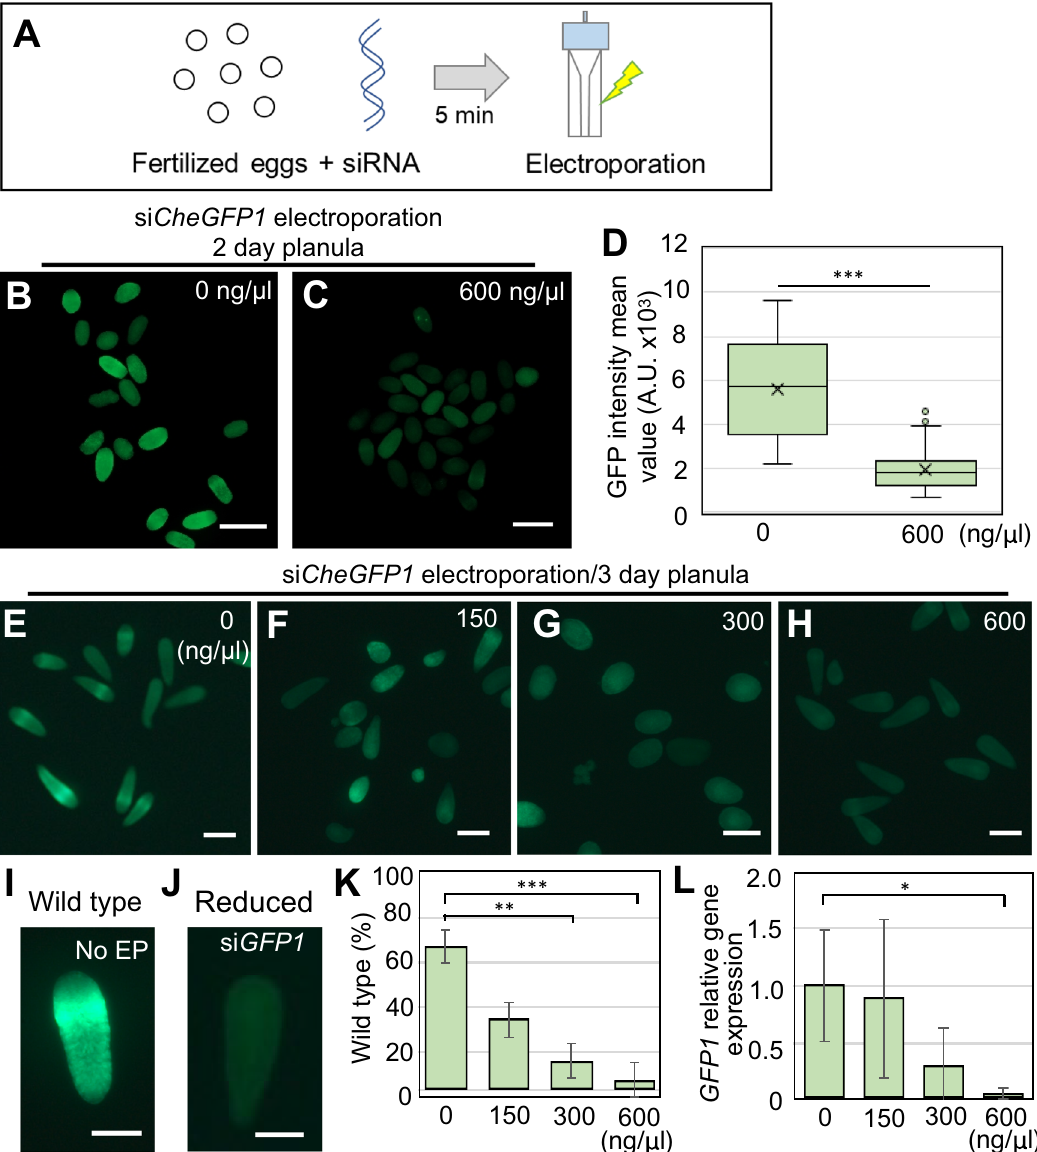
Figure 3. Phenotypes of GFP1 knockdown with siRNA in Clytia fertilized eggs. ( A ) Schematic of the siRNA electroporation procedure using fertilized eggs. Fertilized eggs in 15% Ficoll/artificial sea water mixed with siRNA are incubated for 5 min, and electroporation is conducted after transferring into a cuvette. ( B , C ) Phenotypes of Clytia 2-day planula after CheGFP1 siRNA knockdown. ( D ) Boxplots showing the GFP fluorescence intensity mean values in 2-day planula after electroporation of 0 and 600 ng/µl siRNAs targeting CheGFP1 . Center lines indicate the medians; x’s denote the means; box limits represent the 25th and 75th percentiles; whiskers show the maximum and minimum values. 0 ng/µl, n = 24; 600 ng/µl, n = 81. ***p < 0.001. ( E – H ) Phenotypes of 3-day planula after siRNA targeting CheGFP1 electroporation (0, 150, 300, and 600 ng/µl si CheGFP1 ). ( I , J ) For quantification of green fluorescence, we classified phenotypes into two categories: planula with ring-like green fluorescence as “wild-type,” and planula with reduced green fluorescence as “reduced”. ( K ) Quantification of planula larvae positive for CheGFP1 (wild-type). Bar plots show the percentage of wild-type phenotype after CheGFP1 knockdown. Number of examined planula: 0 ng/µl, n = 82; 150 ng/µl, n = 64; 300 ng/ µl, n = 58; 600 ng/µl, n = 114. Error bars: maximum and minimum values. Experiments were repeated three times. p-values: 150 ng/μl, p = 0.064505; 300 ng/μl, p = 0.001437; 600 ng/μl, p = 0.00066. **p < 0.01, ***p < 0.001. ( L ) Quantification of CheGFP1 mRNA expression levels in 3-day planula by RT-qPCR. CheEF1alpha was used as an internal control. Bar heights represent mean values of at least three independent experiments. CheGFP1 expression levels are standardized relative to the control (0 ng/µl) condition. Error bars: standard deviation. Experiments were performed in triplicated and repeated at least three times. p-values: 150 ng/μl, p = 0.829361; 300 ng/μl, p = 0.08588; 600 ng/μl, p = 0.037359. *p < 0.05. Scale bars: 200